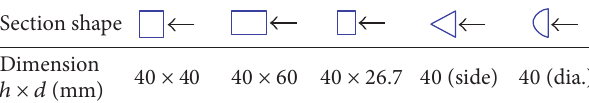
Table 3: Different cross-sections of bluff body in comparative study of Yang et al. [32]. Section